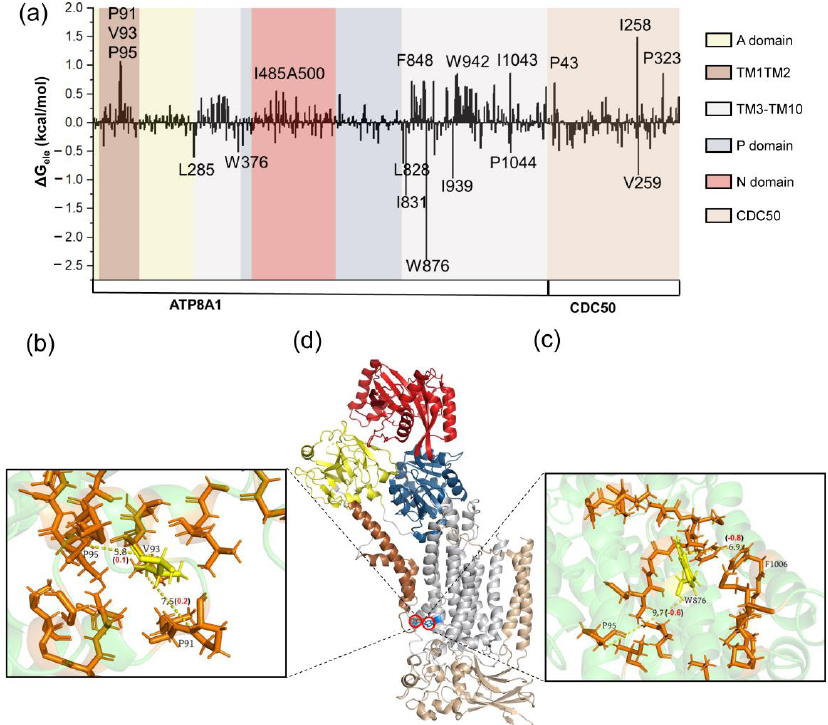
Figure 4. ( a ) The hydrophobic contribution of residues for structures I1 and T1. The interaction map of V94 ( b ), W876 ( c ) and their corresponding position in the P4-ATPase ( d ). The hydrophobic residues are colored orange.